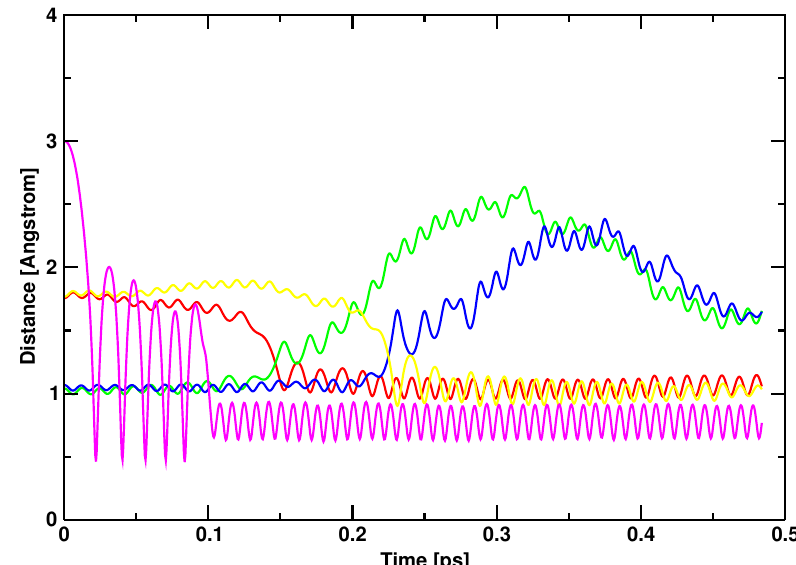
Figure 4. Formation of 1d : Change of distances with time, compare to Figure 3. Green and blue: bonds that are broken. Magenta, red and yellow: bonds that are formed. Initially, molecular hydrogen is formed. The reaction continues with the formation of the N-H bond marked in red. Almost simultaneously the O-H bond marked in green is broken. The breaking of the second N-H bond and the formation of the second O-H bond occur about 0.1 ps